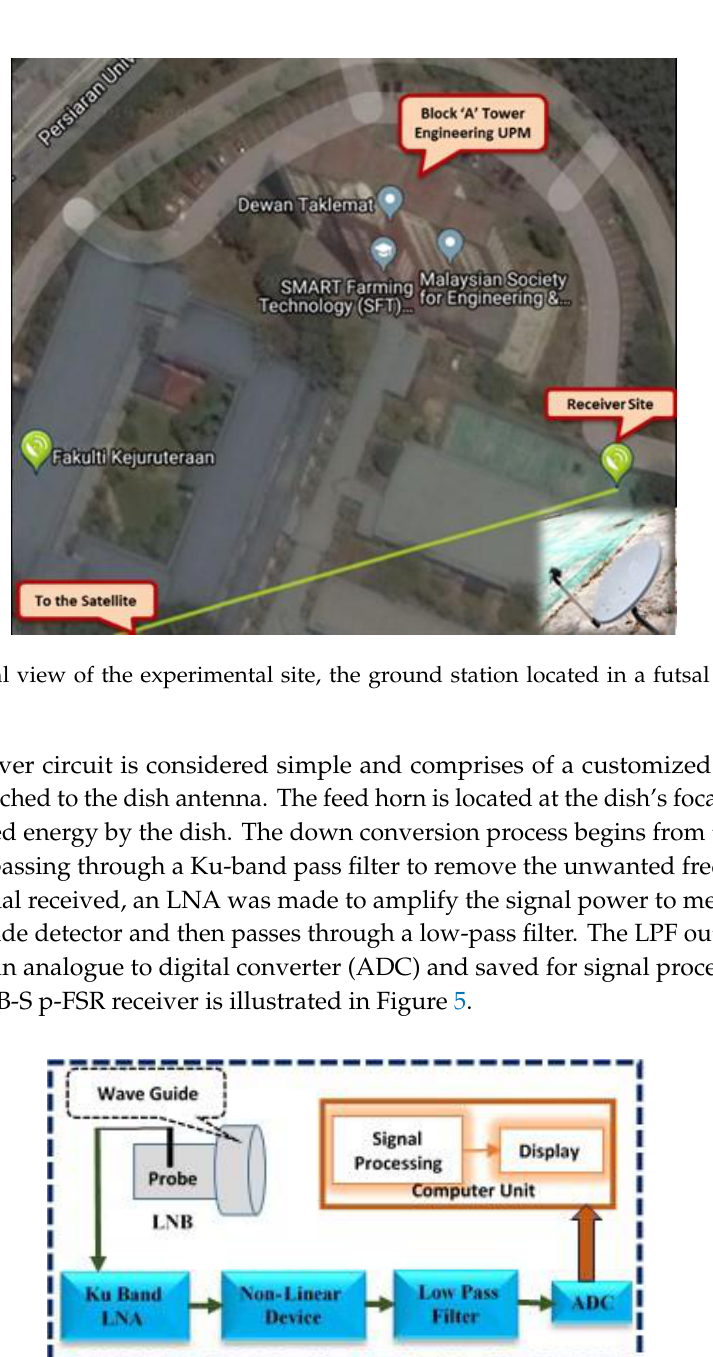
Table 5. Receiver transponders and their power level. Absolute Frequency (GHz)